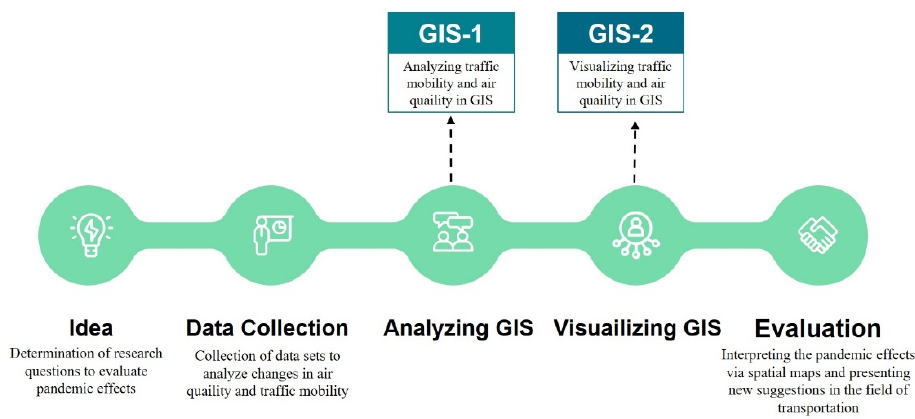
Figure 1. Framework of the paper.